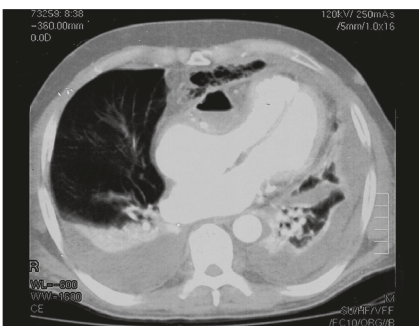
Figure 1: Chest CT scan. The mass is compressing the right ventricle and shifting the heart. Pleural effusion is present, with compression of the left